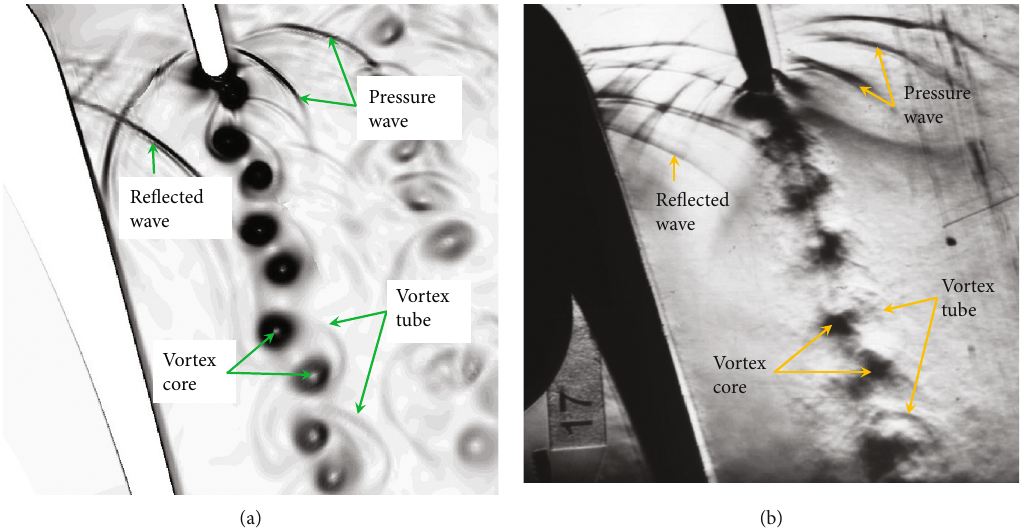
= 0 : 8 : (a) present SAS; (b) experiment ex